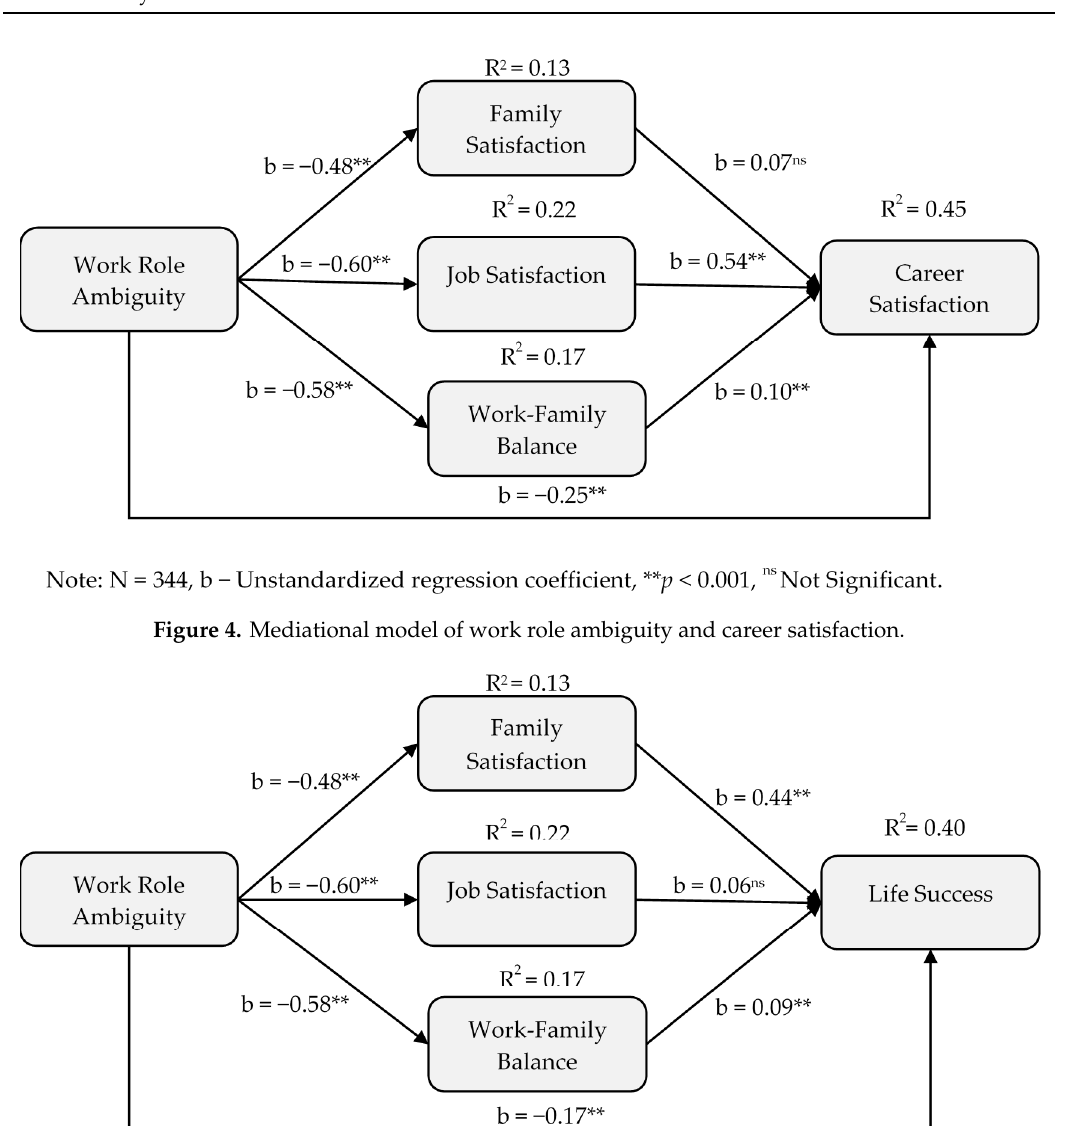
Figure 5. Mediational model on work role ambiguity and life success.